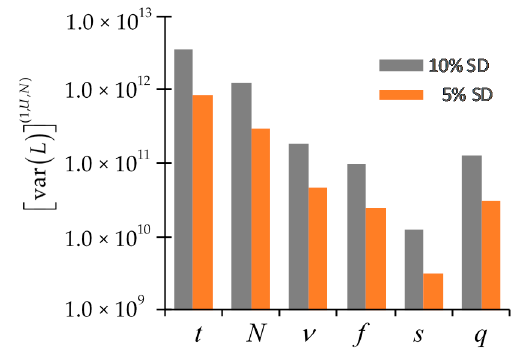
Figure 9. Comparison of [ var ( L )] , i = t , N , ν , f , s , q , due to 5% and 10% standard deviations (SD) of the parameters (considered to be uncorrelated and normally distributed) underlying the total, scattering and fission cross sections, the average number of neutrons per fission, isotopic number densities, and the source parameters, respectively.